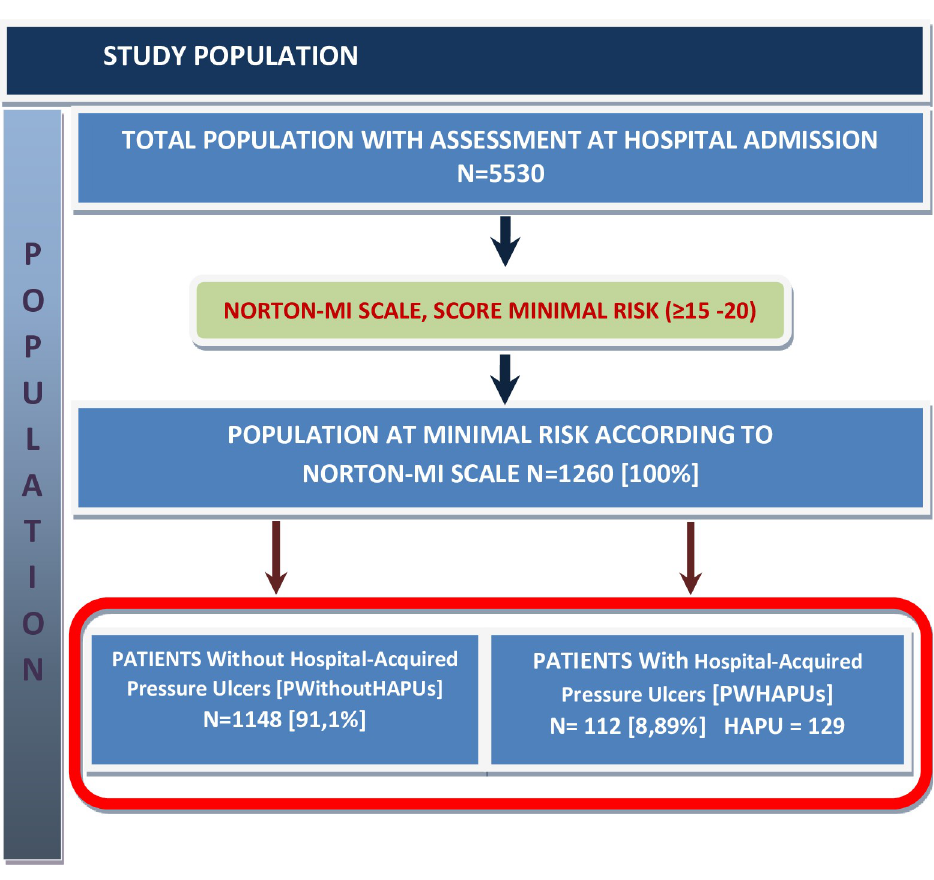
Fig 3. Description of the population under